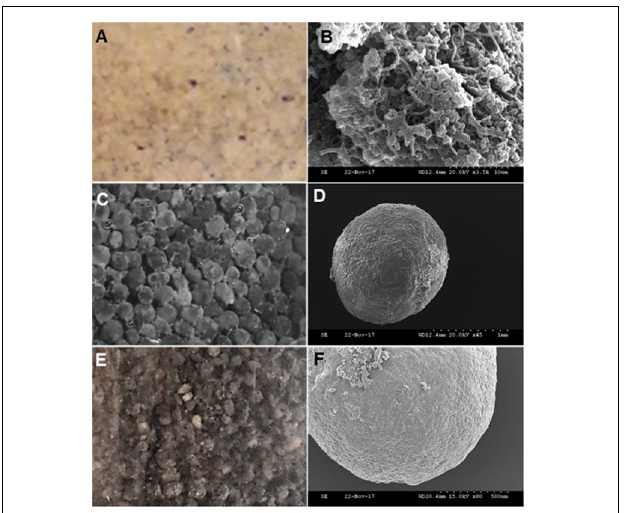
FIGURE 6 | Schematic representation of rapid granulation from inoculum mixture. Sludges prior to inoculation, i.e. flocculent sludge on (A) visual observation and (B) under Scanning Electron Microscopy (SEM) at 10 µ m, and granular sludge on (C) visual observation and (D) under SEM at 1 mm. De novo granulation in the dynamic sludge compartment (DSC) after 8 days on (E) visual observation and (F) under SEM at 500 µ